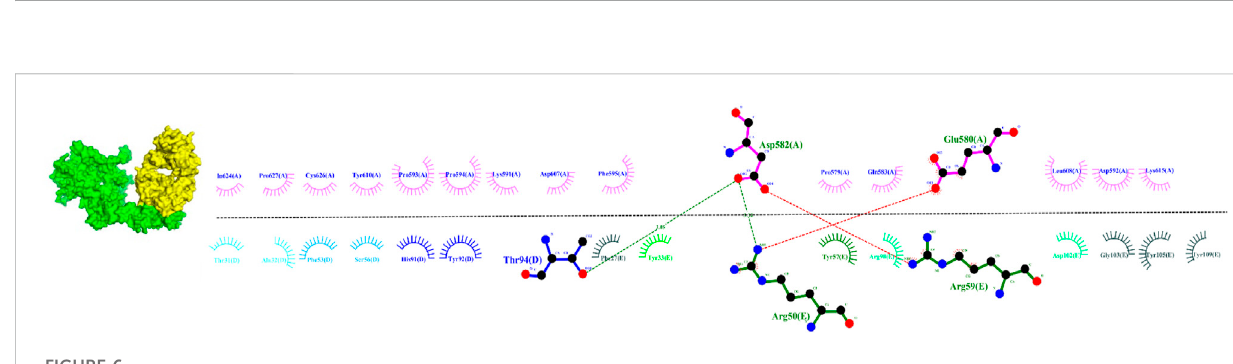
dynamic behaviors of CPs compared with single ricin (black) revealed by the projection of eigenvectors on the fi rst two principal components.